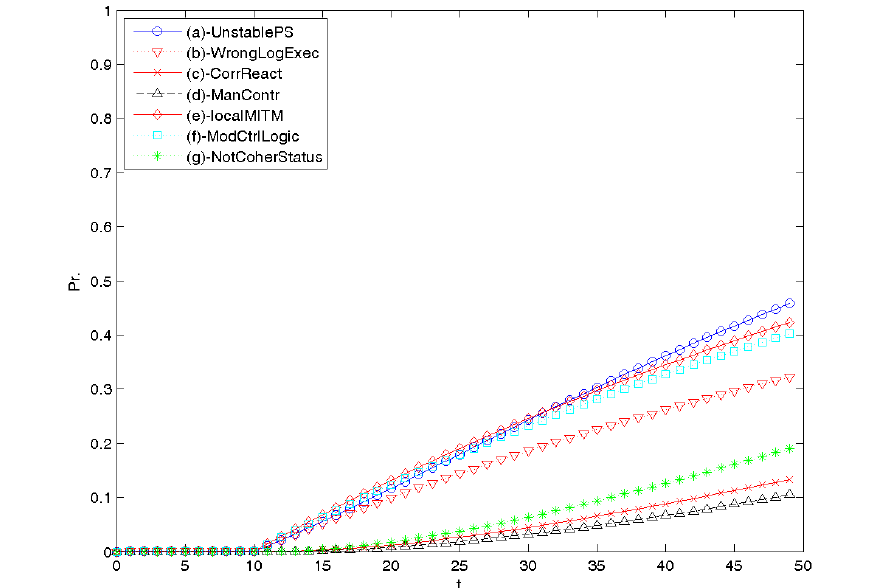
Figure 10. Task: prediction. At time t = 10 on the basis of the observations up to time t , predictions for all subsequent times are computed.